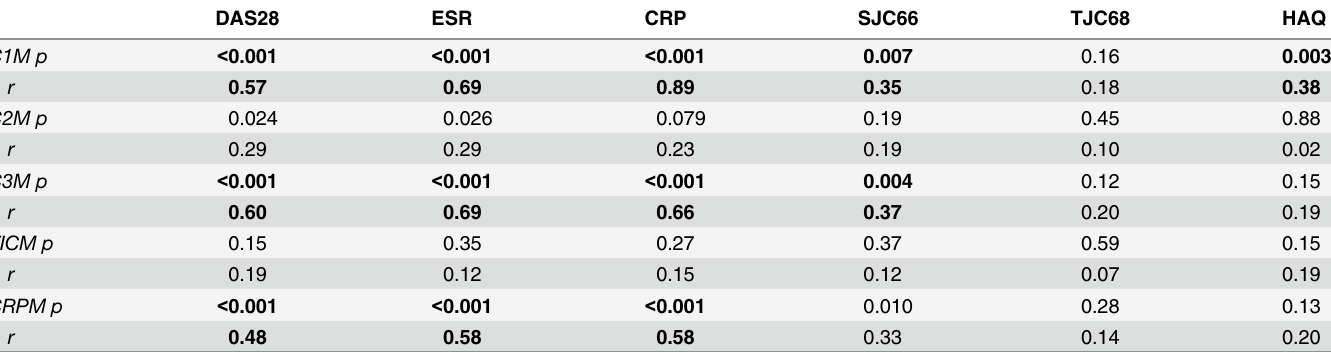
The correlations between the biomarkers of joint destruction and in fl ammation and measures of clinical disease activity in the patients diagnosed with RA at baseline. RA = rheumatoid arthritis; DAS28 = disease activity score in 28 joints; ESR = erythrocyte sedimentation rate; CRP = C-reactive protein; SJC66 = 66 swollen joint score; TJC68 = 68 tender joint score; HAQ = health assessment questionnaire; C1M = matrix metalloproteinases (MMP) degraded type I collagen; C2M = MMP degraded type II collagen; C3M = MMP degraded type III collagen; VICM = citrullinated and degraded